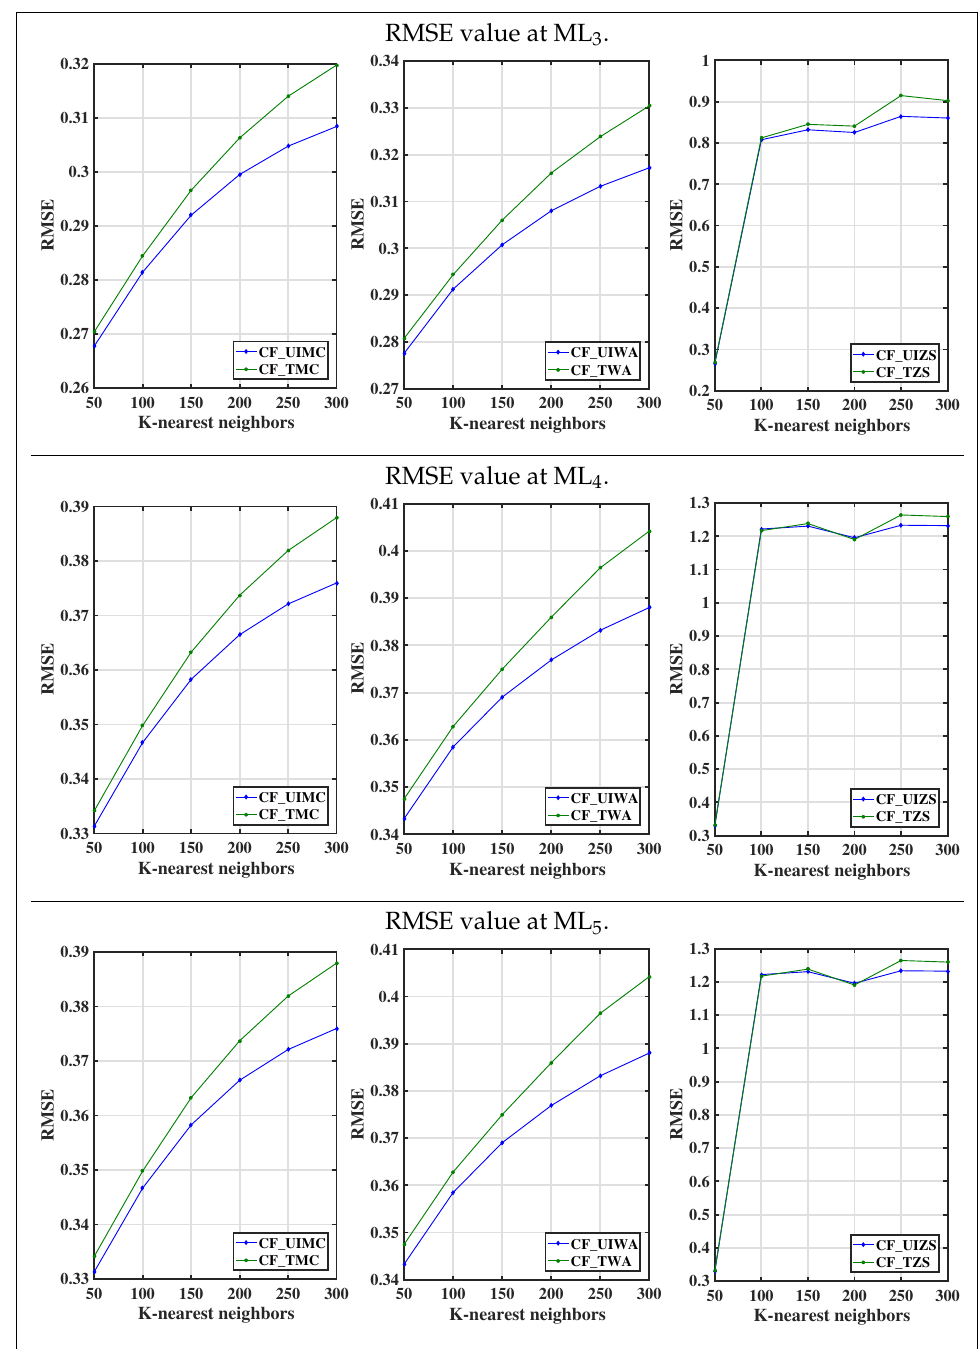
Figure 5. RMSE Value at